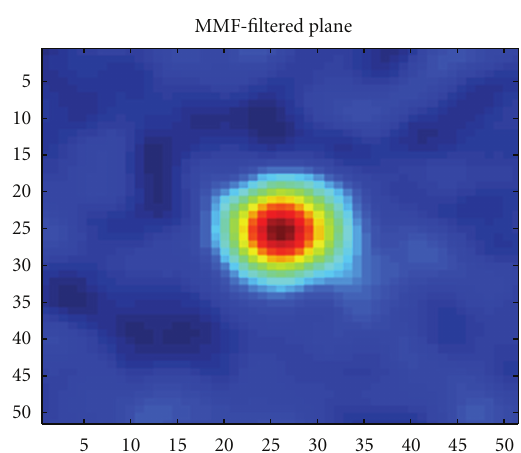
Figure 4: The same area of the simulated sky as in Figure 3, after filtering with MMF. Now the galaxy cluster is clearly visible. Similarly, it is possible, albeit less interesting, to design filters that give the thermal SZ e ff ect while cancelling the bias introduced by the kinematic e ff ect. Both families of filters are called unbiased matched multifilters